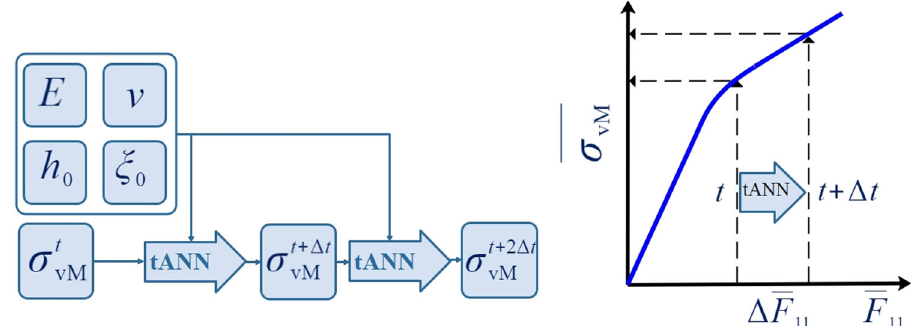
Fig. 10 Schematic illustration of the tANN for calculation of the local von Mises stress based on J 2 viscoplasticity with linear isotropic hardening. a Young ’ s modulus E , Poisson ’ s ratio ν , initial fl ow resistance ξ 0 , and linear isotropic hardening modulus h 0 are material property distributions as input of the tANN. σ t denotes the von Mises stress distribution at time step vM